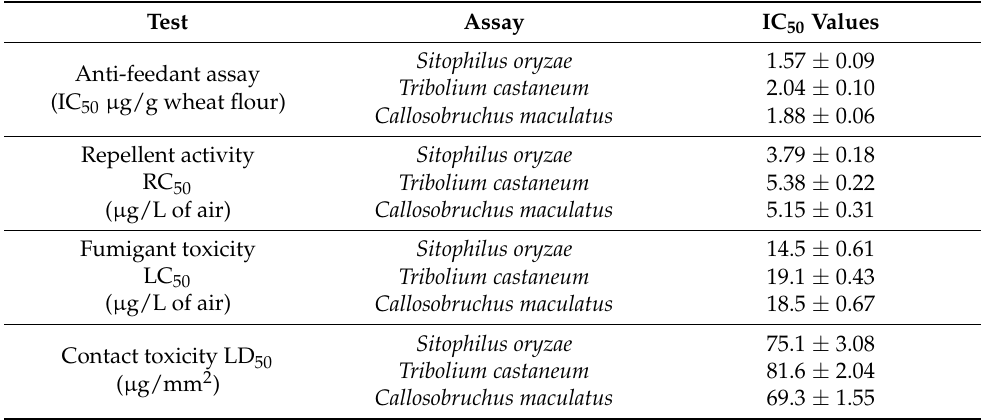
Table 2. The insecticidal properties of Pimenta dioica (Allspice) essential oil extracted by steam dis- tillation estimated in terms of repellent efficacy, contact toxicity, and fumigant toxicity.